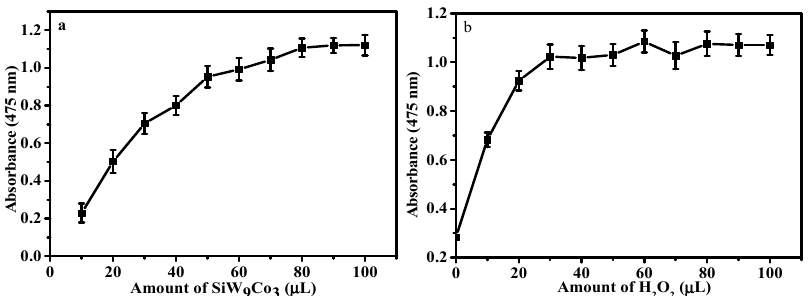
Figure 6. Effect of the amount of SiW 9 Co 3 ( a ) and H 2 O 2 ( b ) for the detection of DA. ( a ) 120 µ L DA, 60 µ L H 2 O 2 ; and ( b ) 80 µ L SiW 9 Co 3 , 120 µ L DA, and reaction time of 10 min.